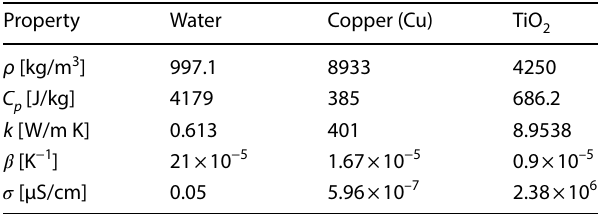
Table 1 Thermophysical properties of water, Copper, and Titanium [69–71]